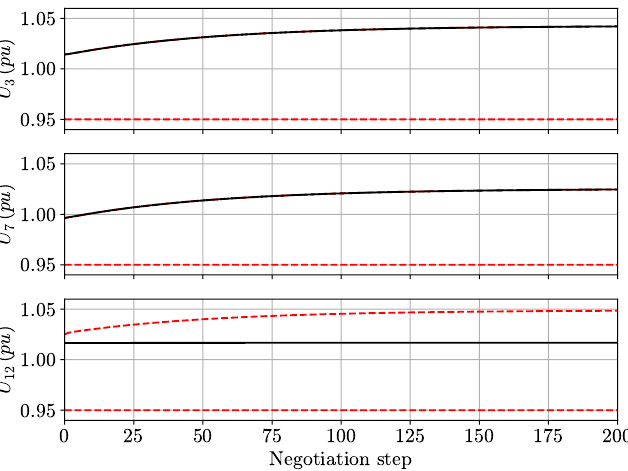
Figure 3. Buses 3, 7, and 12 negotiation and the associated constraints (dashed